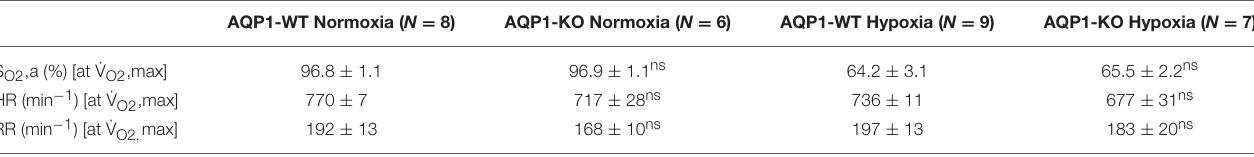
TABLE 2 | Results of pulse oximetry in AQP1-KO and WT